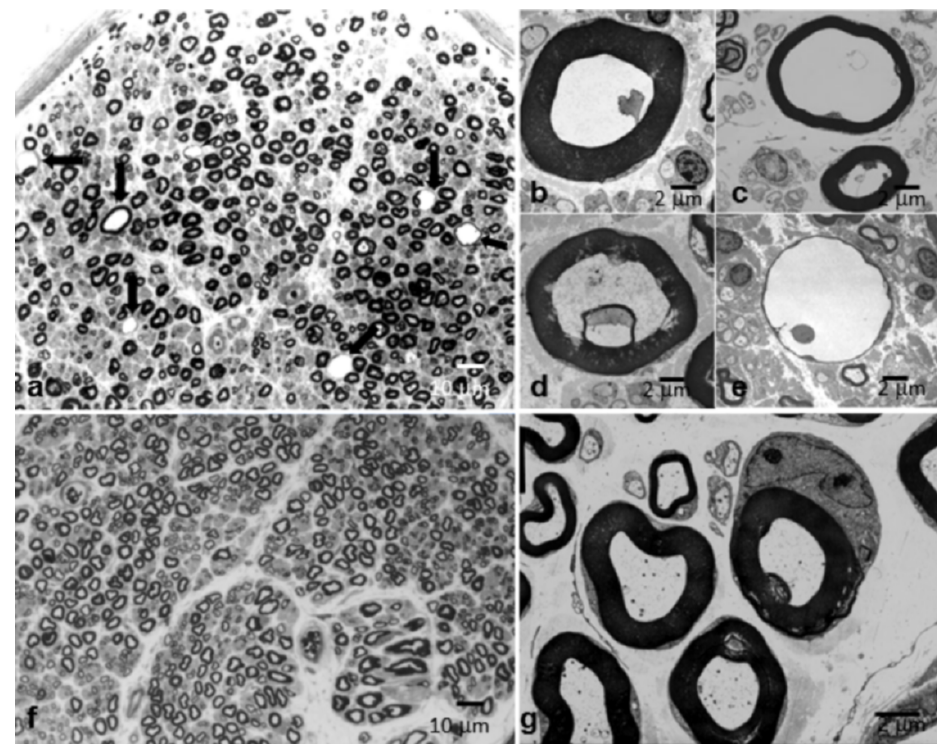
Figure 8. Sural nerve biopsy from a 58-year-old man with “typical” CIDP ( a ). Semithin sections stained with toluidine blue ( a ). Numerous fibers appear vacuolated (arrows in (a)) and show a distension and thinning of the myelin sheath (a). Electron microscope ( b–e ). Sural nerve biopsies from a 63-year-old woman with “typical” CIDP ( b ); from a 58-year-old man with “typical” CIDP (shown in (a)) ( c ); from a 61-year-old man with “typical” CIDP ( d ); and from the 65-year-old man with “atypical” CIDP (MADSAM) shown in Figures 5a,b and 7c ( e ). Intramyelinic edema appears as a finely granular fluid material that relaxes and deforms the myelin sheath. The fibers a ff ected have a swollen appearance with axons invariably show a marked reduction in diameter, as shrunk by osmotic mechanisms. ( f ) Semithin